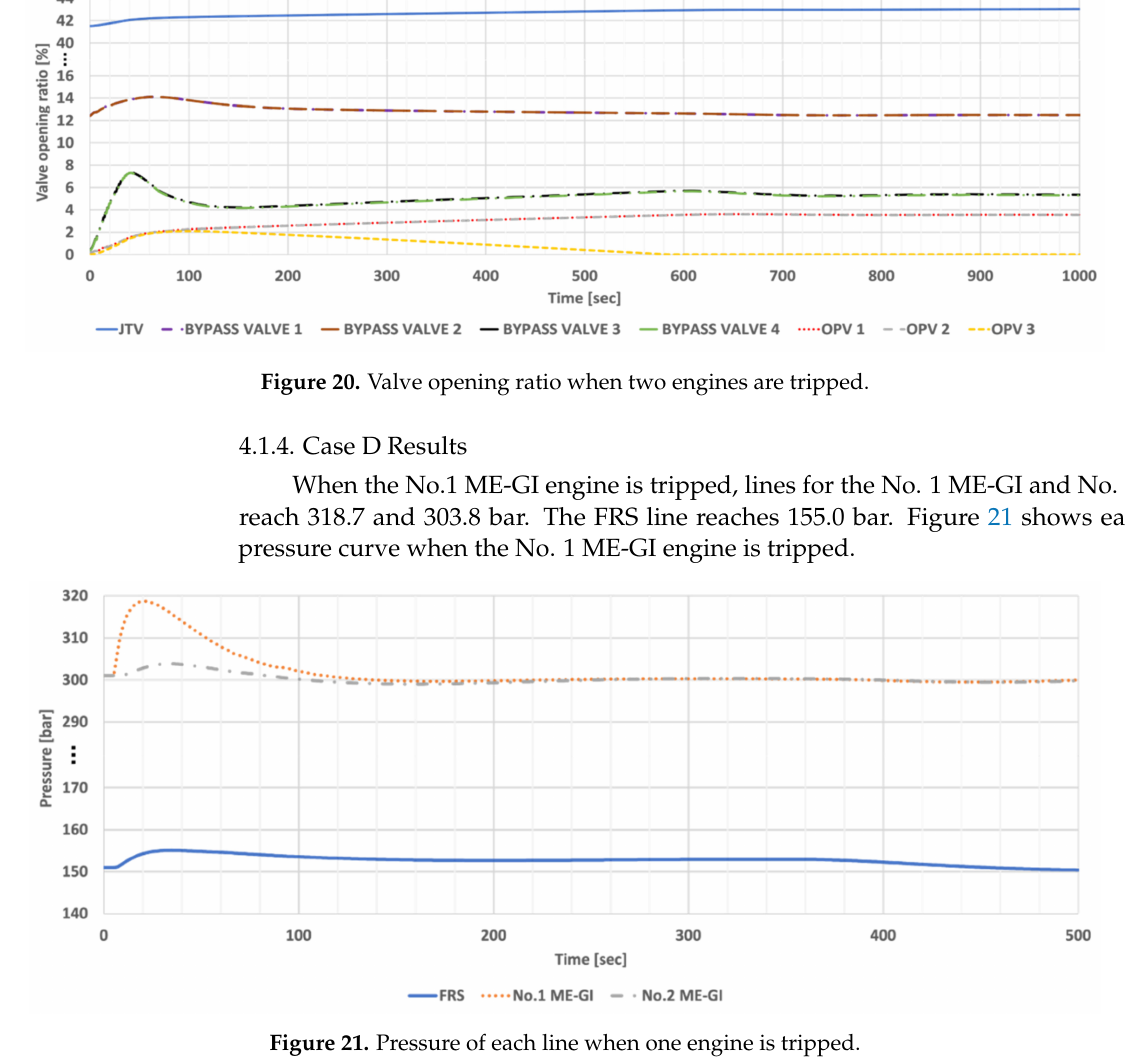
Figure 21. Pressure of each line when one engine is